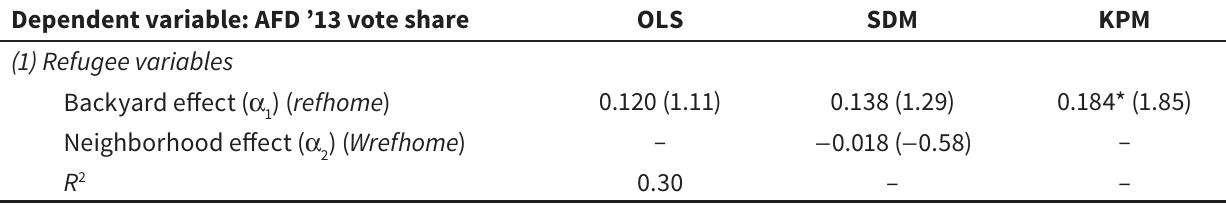
Placebo regression for the AFD vote shares in the year 2013 in percentage points Dependent variable: AFD ’13 vote share